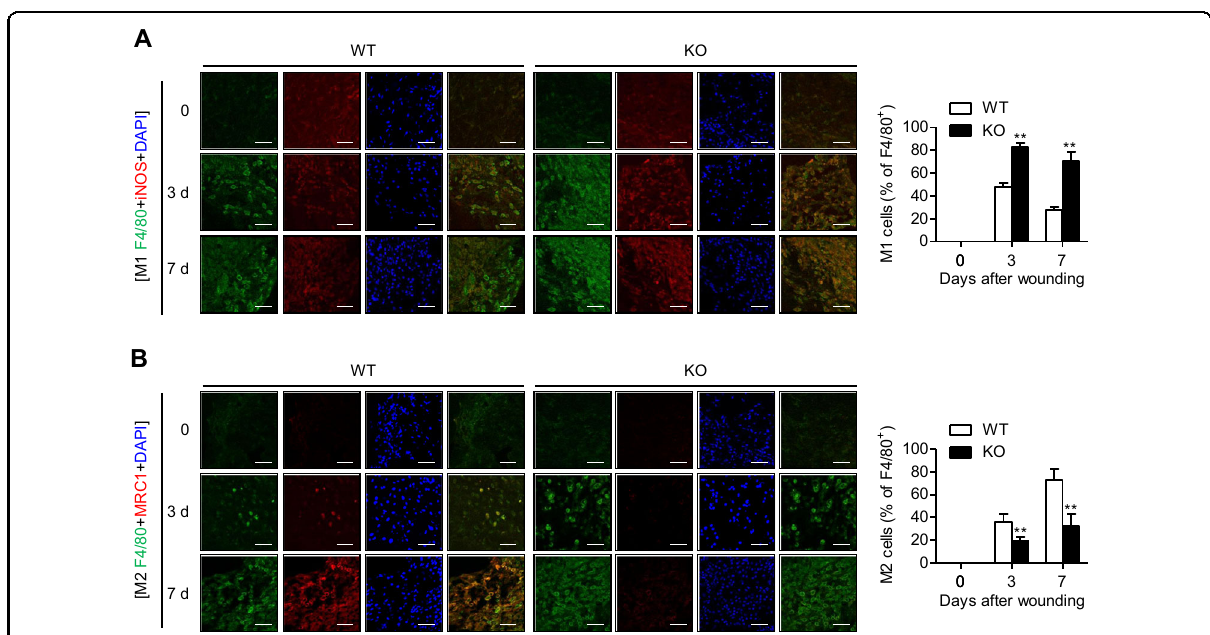
Fig. 4 Decrease in the number of M2 macrophages in wound sites in mS6KO mice. The skin wounds of WT and KO mice were double stained for F4/80 and iNOS to identify M1 macrophages ( a ) or F4/80 and MRC1 to identify M2 macrophages ( b ). Digitally merged signals are shown in the right panels. Bars = 50 μ m. Representative results from three independent experiments are